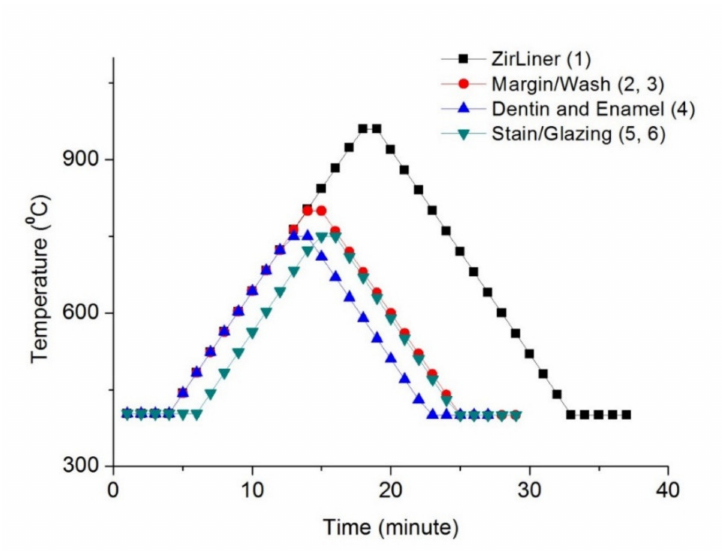
Figure 1. Firing schedule of sintered zirconia (ZirLiner: zirconia lining